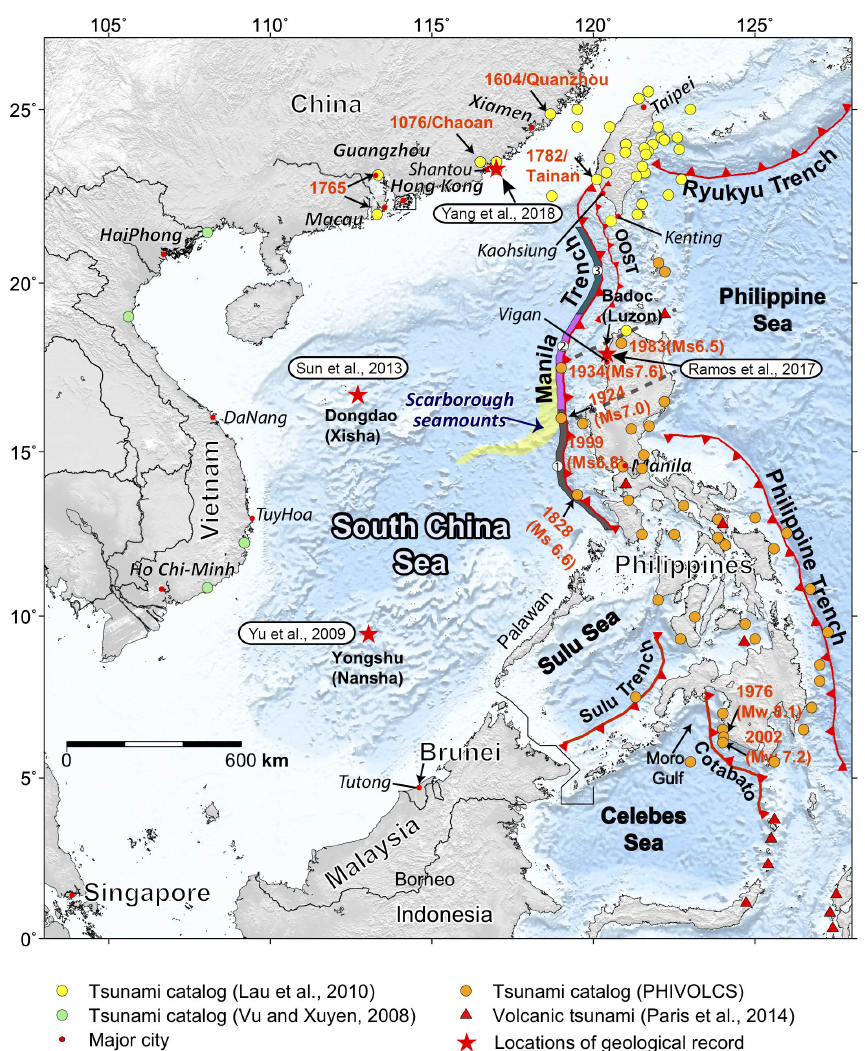
Figure 1. Tectonic setting and historical tsunami catalogs in the South China Sea region. Colored circles indicate published tsunami cat- alogs and are labeled in the legend. Red triangles represent historical tsunamis related to volcanic activities. Red barbed curves show the megathrusts in this region. Geological tsunami records are marked with red stars (Ramos et al., 2017; Sun et al., 2013; Yang et al., 2018; Yu et al., 2009). The megacities are labeled in the legend and the seafloor subducting features are highlighted in the map. The historical earthquakes with M w > 6 . 5 in the Philippines are labeled. The likely tsunami events reported in the megacities are also labeled in the map. The two dashed lines represent the possible trace of the subducted Scarborough seamounts underneath the overriding plate as imaged from the tomography study (Wu et al., 2016). The rupture zones are denoted by the colored–shaded